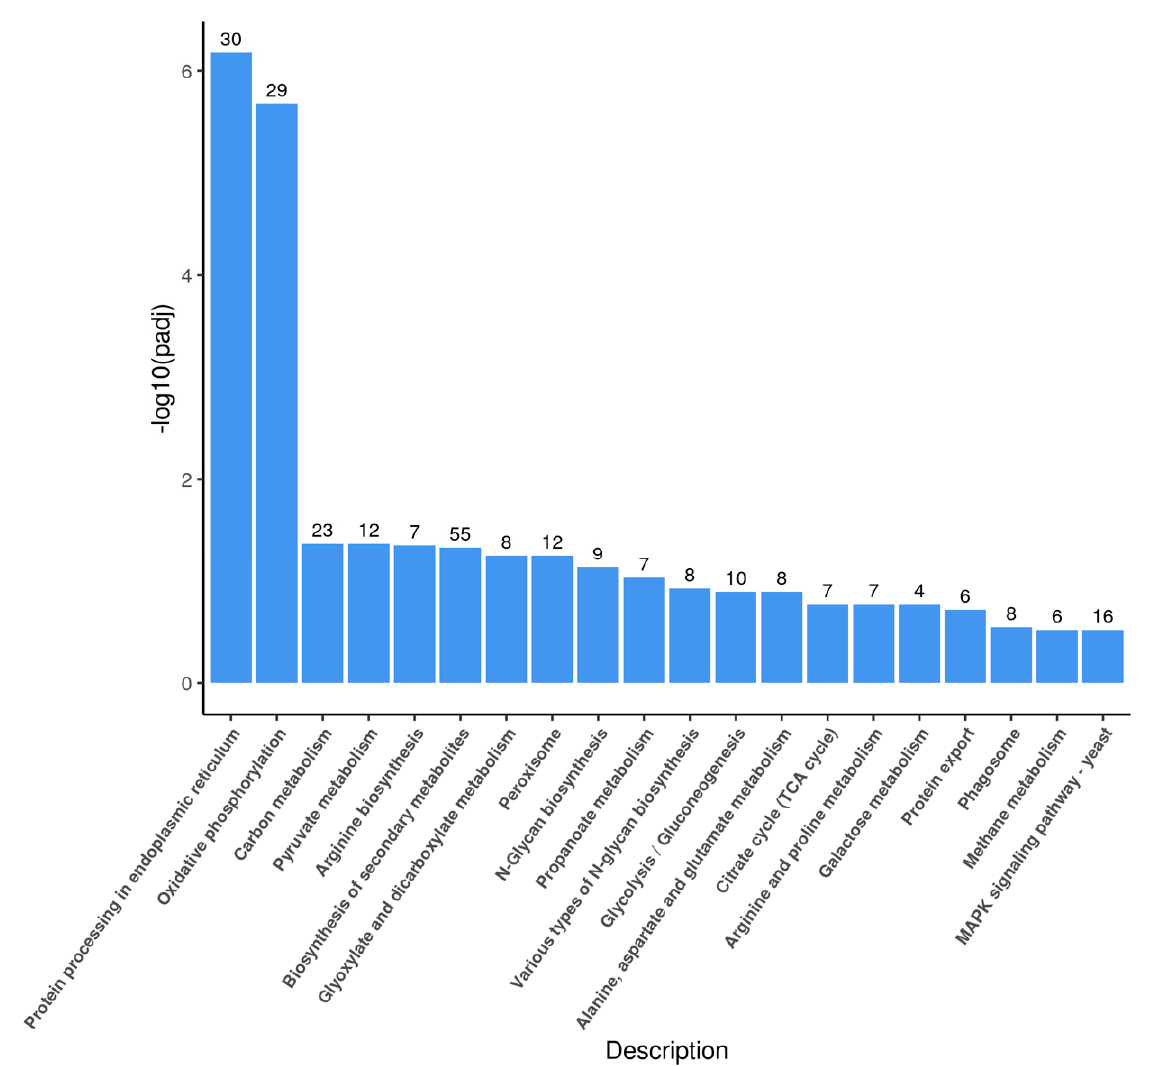
Figure 6. Categorization of Kyoto Encyclopedia of Genes and Genomes (KEGG) function for DEGs in P. pastoris cells. The ordinate ( − log10 (padj)) represents the significance level of GO term enrichment, and the numbers above the graphs indicate the number of genes differentially expressed; p -values < 0.05 were designated as differentially expressed genes (DEGs).